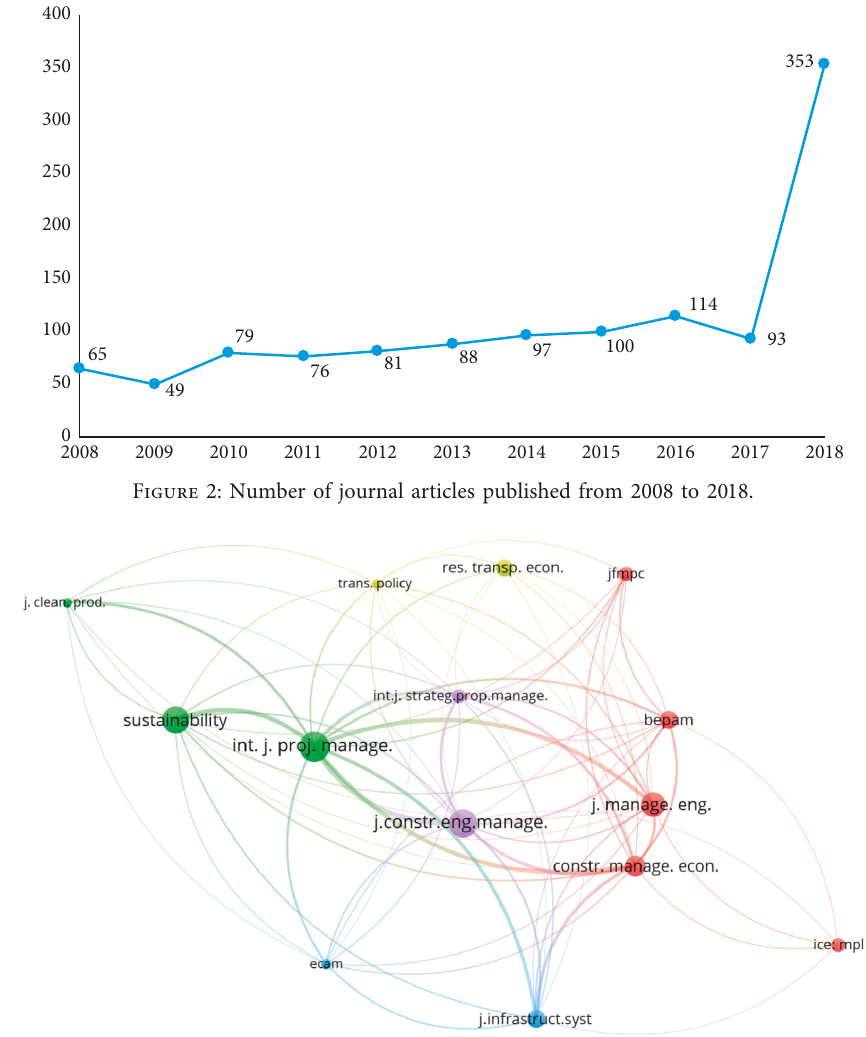
Figure 3: Mapping of sources of journal articles within this research. Note: Journal names are presented in Figure 2 using acronyms or abbreviation. The full name of journals can be found in Table